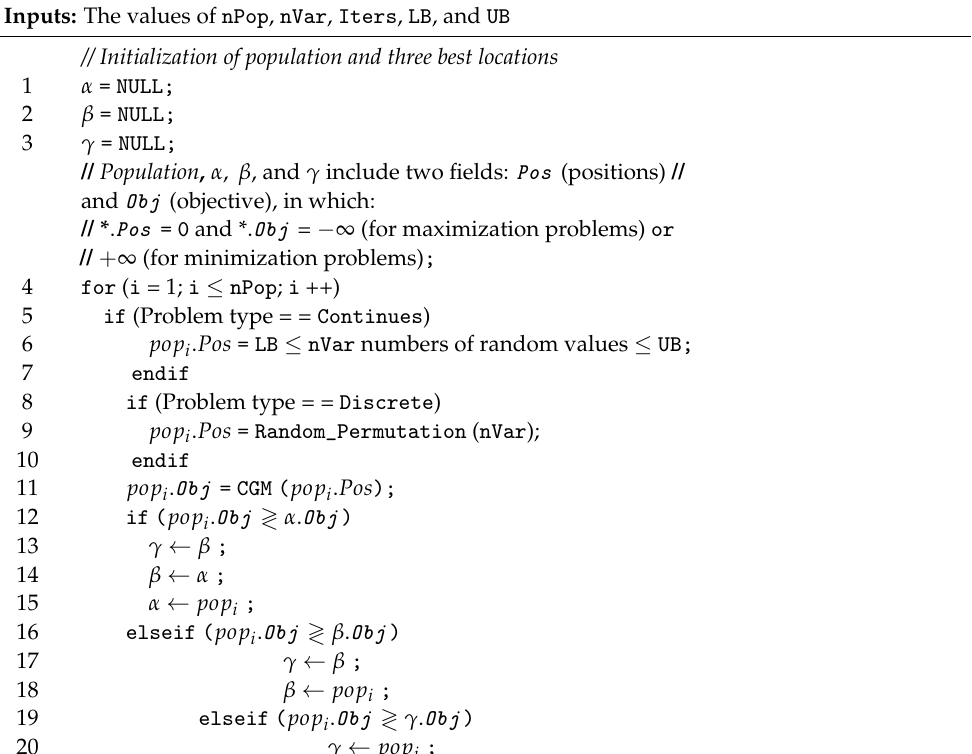
Algorithm 1 The proposed CGM optimization